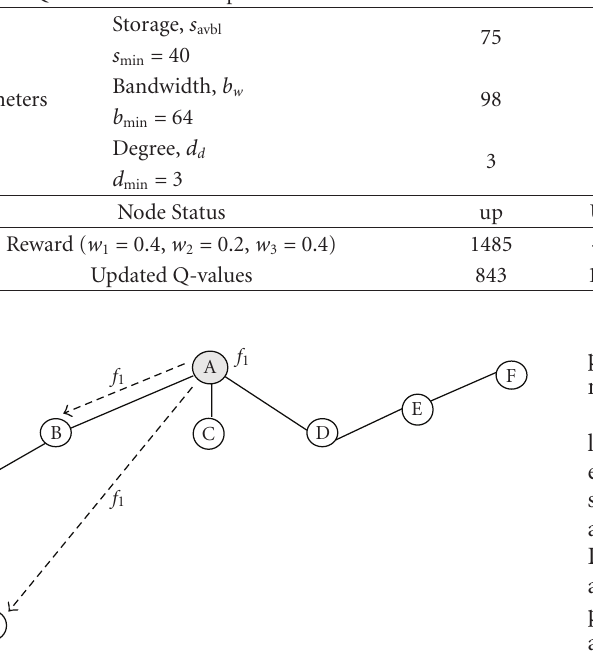
Figure 5: Replication of object “ f 1 ” to nodes B and